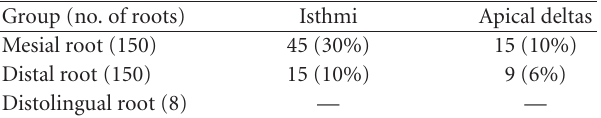
Table 3: Frequency of isthmi and apical deltas in mesial and distal